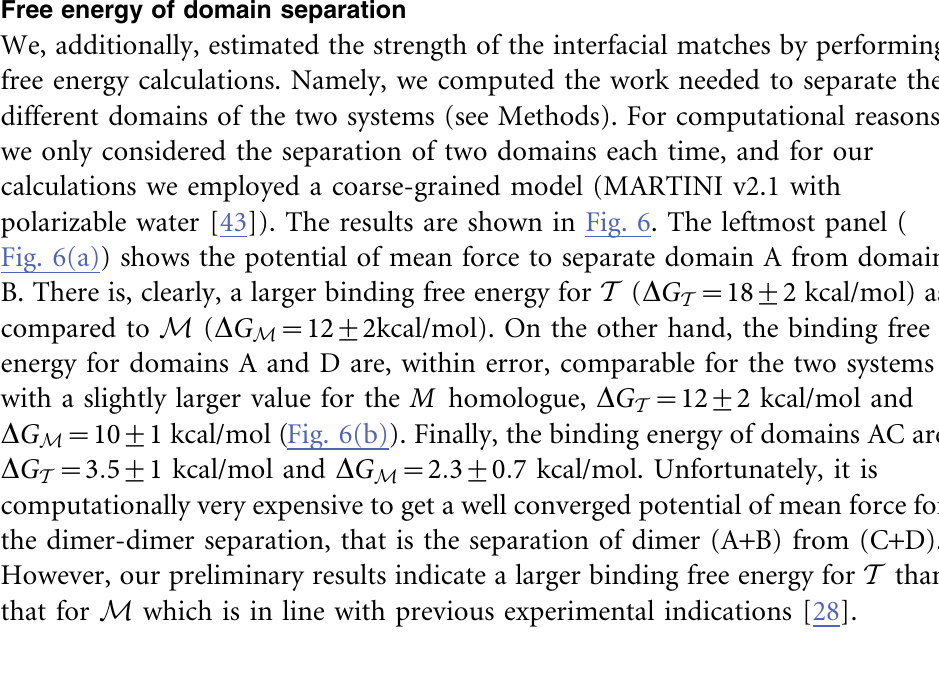
Errors correspond to standard